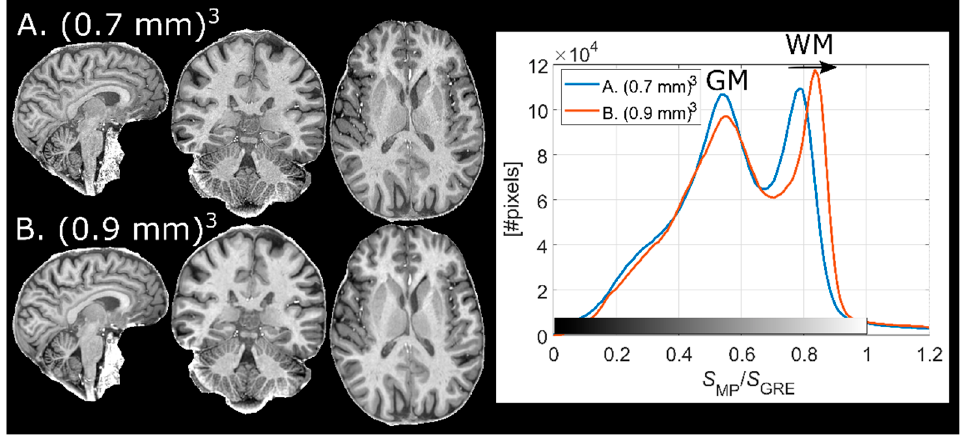
Figure 3. Normalized MPRAGE images acquired on the same subject with two protocols with different resolutions. ( A ) (0.7 mm) 3 , and ( B ) (0.9 mm) 3 . At 0.9 mm isotropic resolution, WM pixel values are increased (black arrow in histogram plot) relative (0.7 mm) 3 while GM pixel values remain largely unaffected, increasing tissue contrast. This is an effect of the shortened readout train (lower TF).